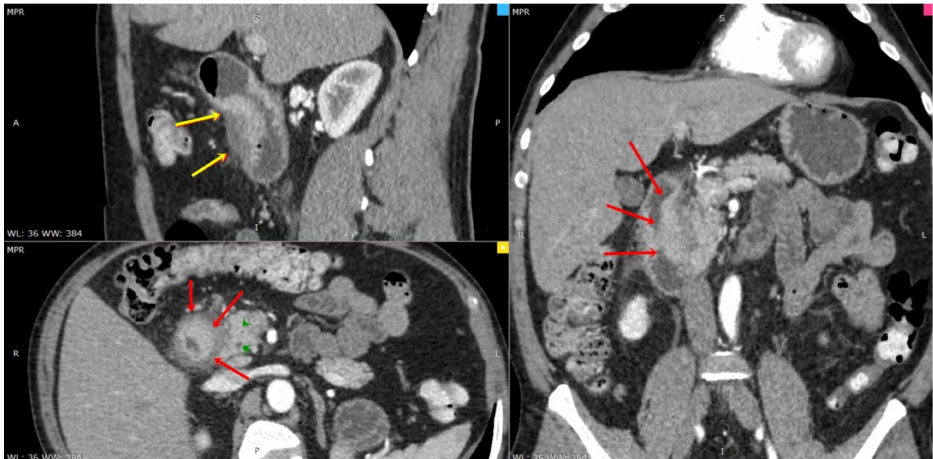
Figure 4. CT multiplanar reconstruction (CT-MPR) in the arterial phase revealed extended thickening of the duodenal wall (red arrows) and fluid wrapping duodenal and duodenal–pancreatic groove (yellow arrows) without signs of chronic pancreatitis or involvement of bile ducts (main biliary duct and Wirsung duct, green arrowheads). (A) Anterior part of the patient. (R) The right of the patient. (P) Posterior part of the patient. (L) The left of the